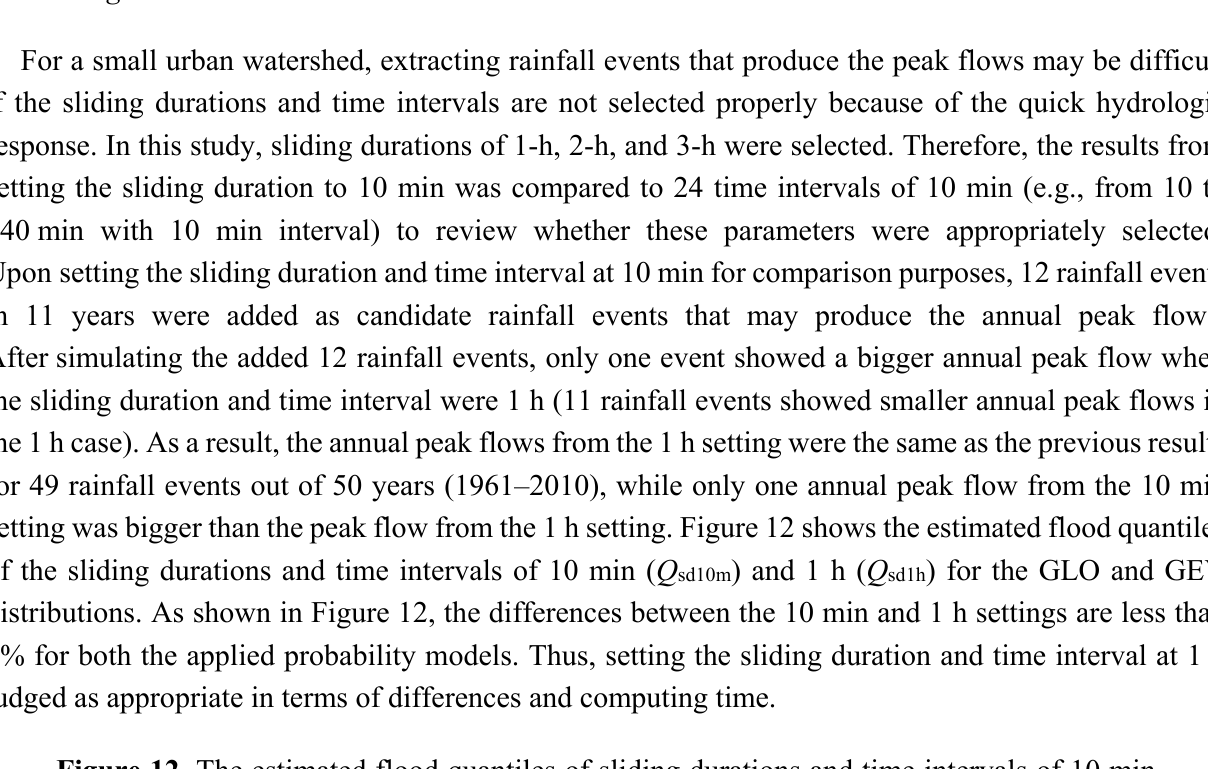
Figure 12. The estimated flood quantiles of sliding durations and time intervals of 10 min and 1 h for the GLO and GEV